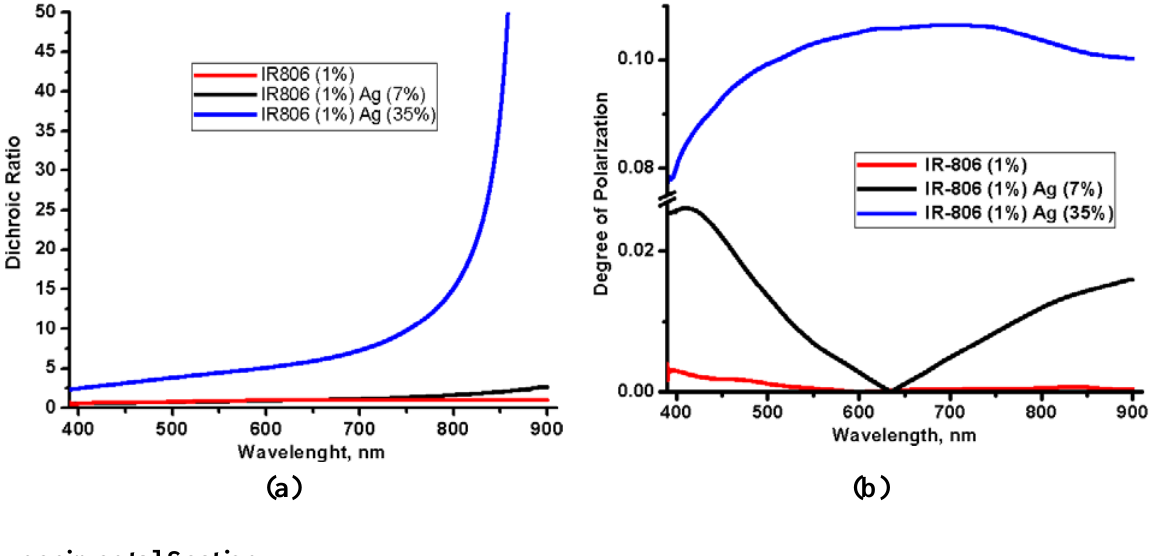
Figure 4. (Color online) ( a ) Dichroic ratio and ( b ) degree of polarization of reference layer of IR-806 (red), Samples No. 2 (black), and Samples No. 3